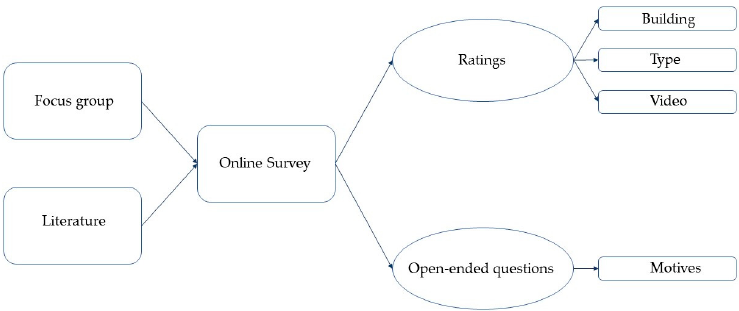
Figure 1. Diagram study design.